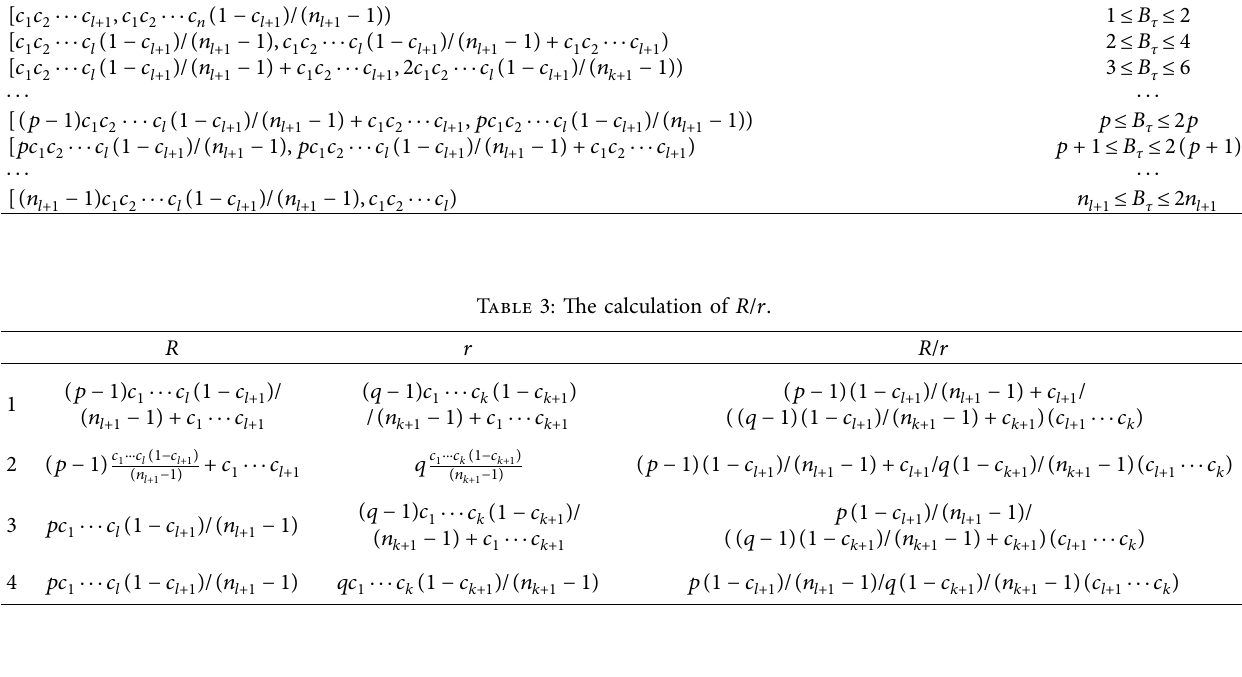
Table 2: The calculation of B